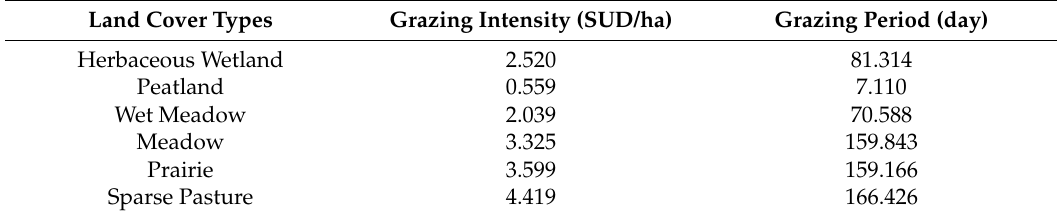
Table 6. Annual average grazing intensity and annual grazing period for different land cover